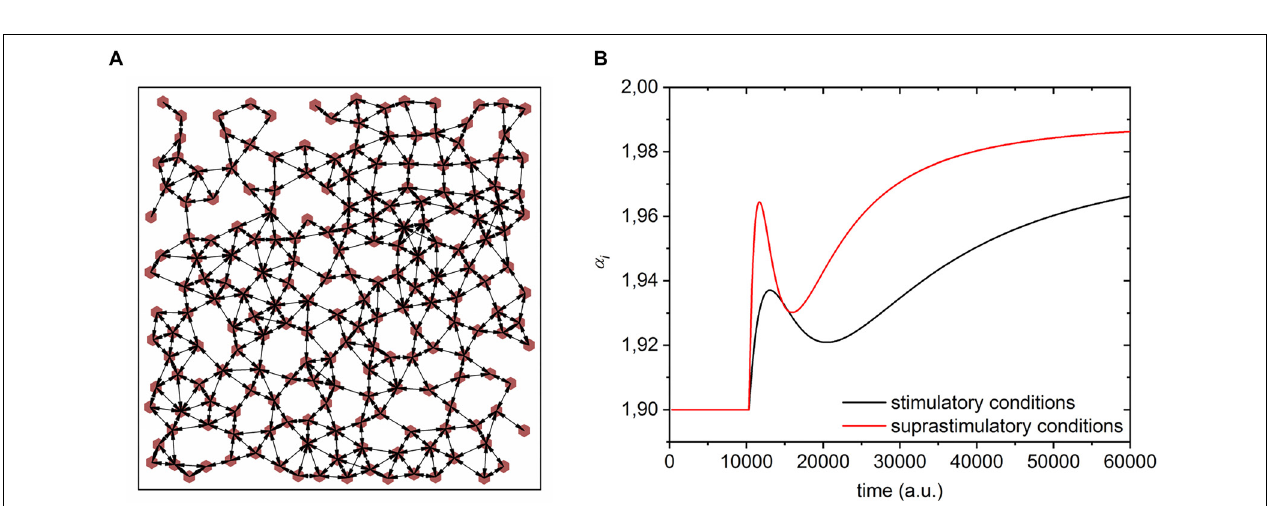
FIGURE 2 | Features of the phenomenological model of beta cell population. (A) A typical simulated beta cell network architecture. Red dots denote individual cells and the arrows depict intercellular electrical coupling. (B) Simulated time course of beta cell excitability rate after switching from substimulatory to stimulatory ( (cid:49) α = 0 . 08, A = 0 . 45, B = 0 . 0004, T ( 8 ) m , i = 35000, t s = 10000) and suprastimulatory ( (cid:49) α = 0 . 09, A = 0 . 70, B = 0 . 0008, T ( 12 ) m , i = 20000, t s = 10000) conditions.